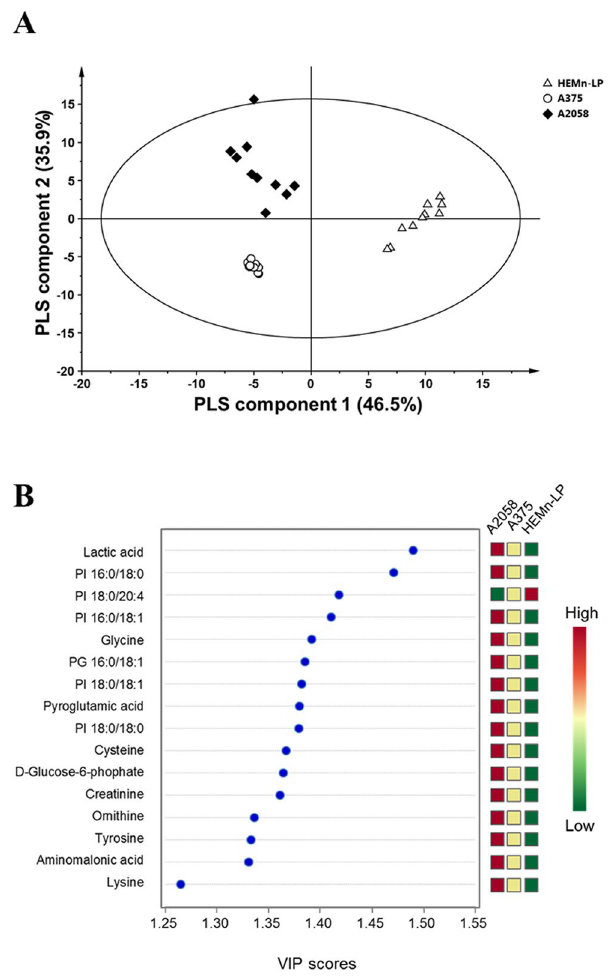
Figure 2. PLS-DA analysis based on metabolic and lipidomic data. ( A ) PLS-DA-derived score plot from melanocytes and two melanoma cell lines ( n = 10 for each group) and ( B ) important metabolites and lipids selected based on VIP scores.